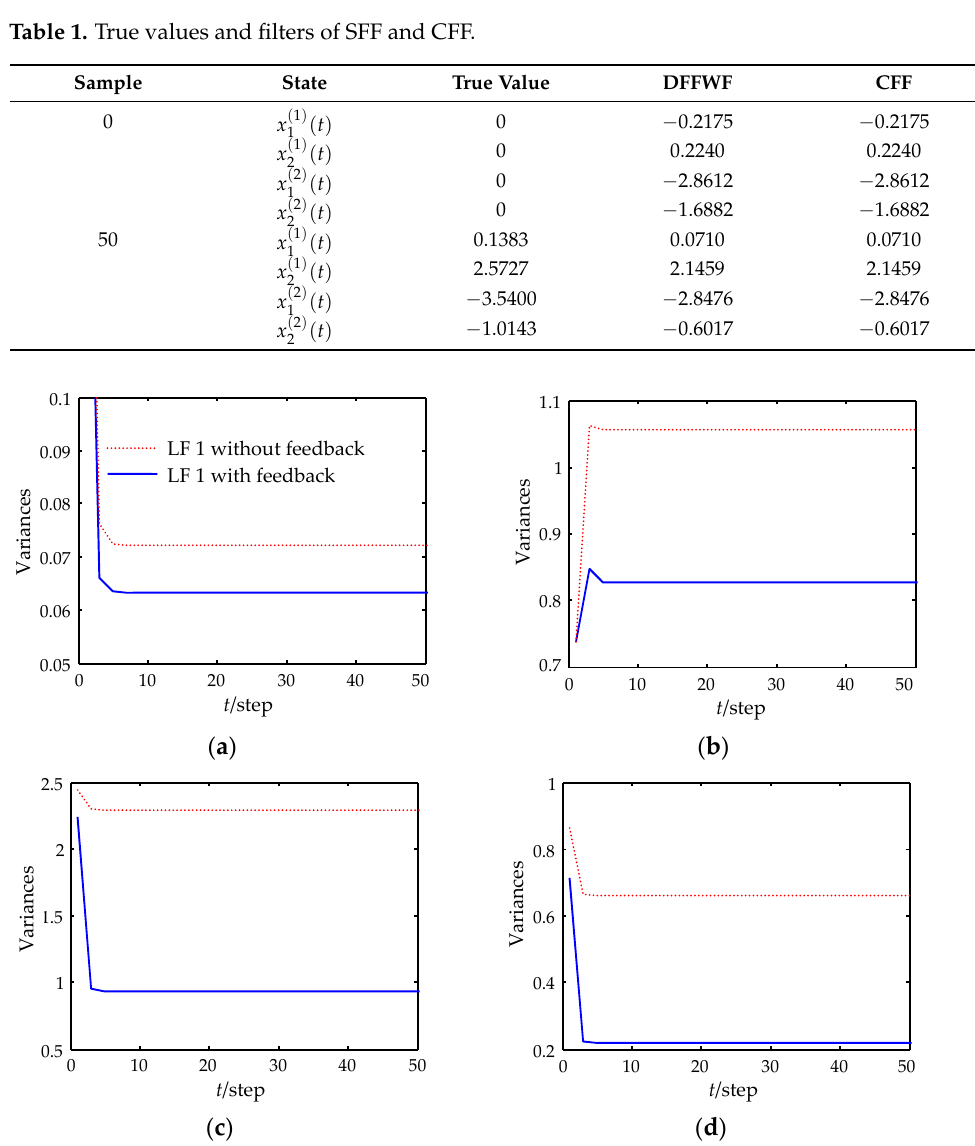
( d ) Figure 2. Tracking performance of DFFWF and CFF. ( a ) The first state component. ( b ) The second state component. ( c ) The third state component. ( d ) The fourth state component.